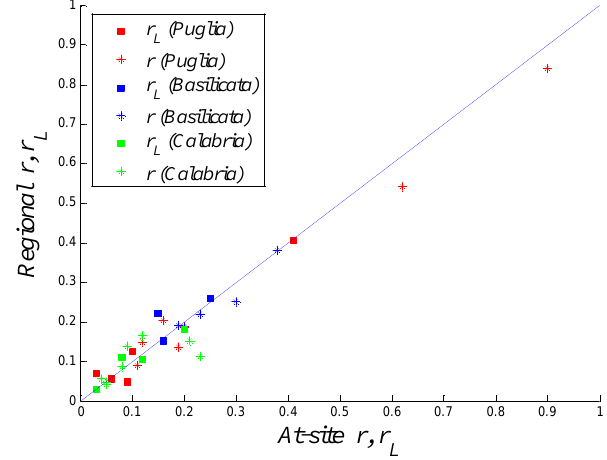
Fig. 5. Comparison between the at-site and regional estimates of r H in river basins showing the extraordinary component.